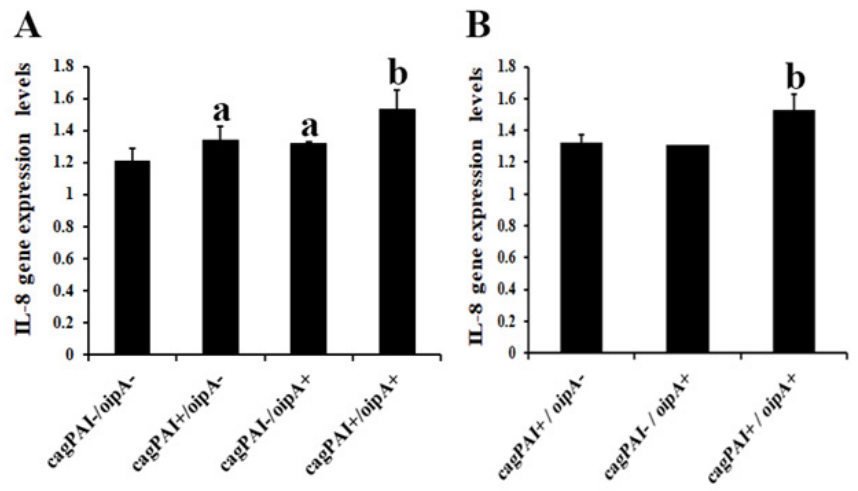
Fig. 2 . IL-8 gene expression levels in the presence/absence of oip A and cag PAI genes in gastric tissues of subjects with gastritis (A) and PUD (B). a significant differences when compared with double-negative cag PAI / oip A gene status ( p <0.05). b significant differences when compared with single-positive oip A, cag PAI gene status, or double-negative for these two genes ( p